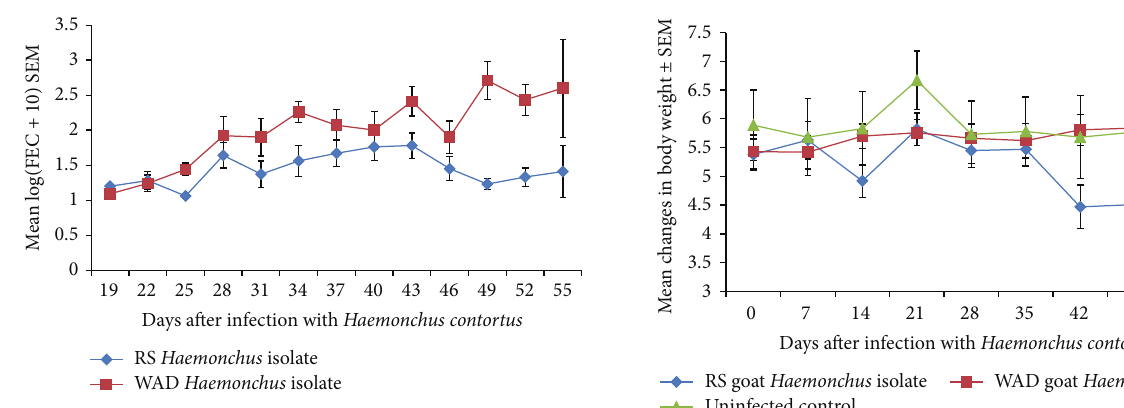
Figure 1: Mean strongyle egg counts of Nigerian West African Dwarf (WAD) goats given a single pulse infection with either a Red Sokoto (RS) or a WAD goat isolate of H. contortus .